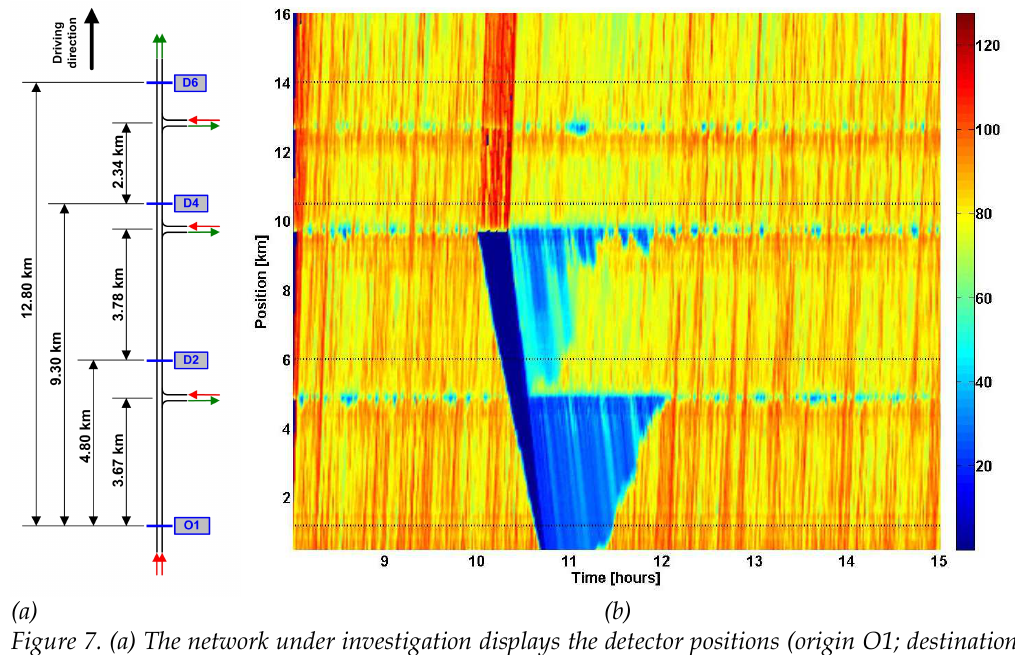
Figure 7. (a) The network under investigation displays the detector positions (origin O1; destinations: D2, D4 and D6) together with the relevant distances. (b) Time-space view of the average speed (over both lanes) for scenario 2 and the whole simulation